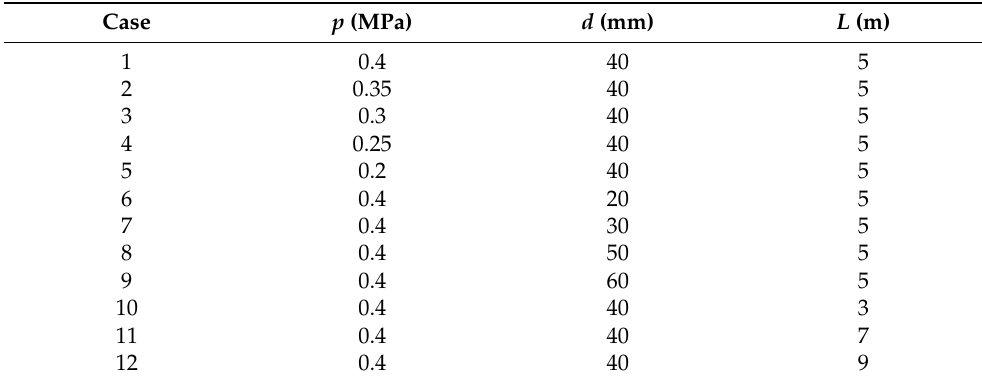
Table 1. Working